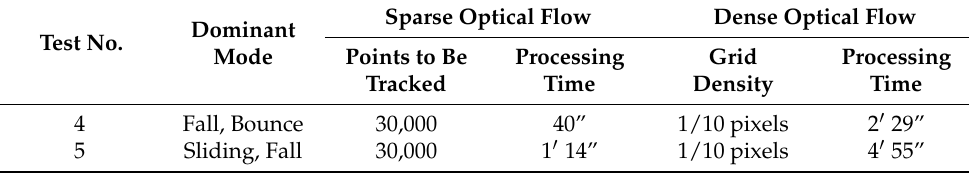
Table 3. Comparison of processing time between sparse and dense optical flow methods. Test